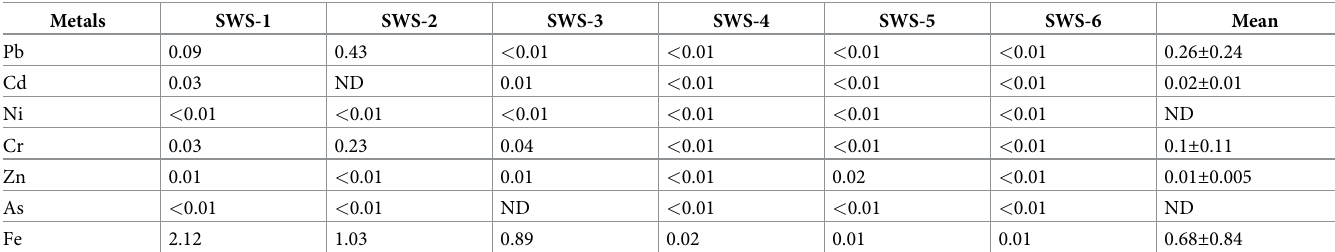
Table 5. Heavy metal concentrations (mg/L) in landfill impacted surface water during the dry season.